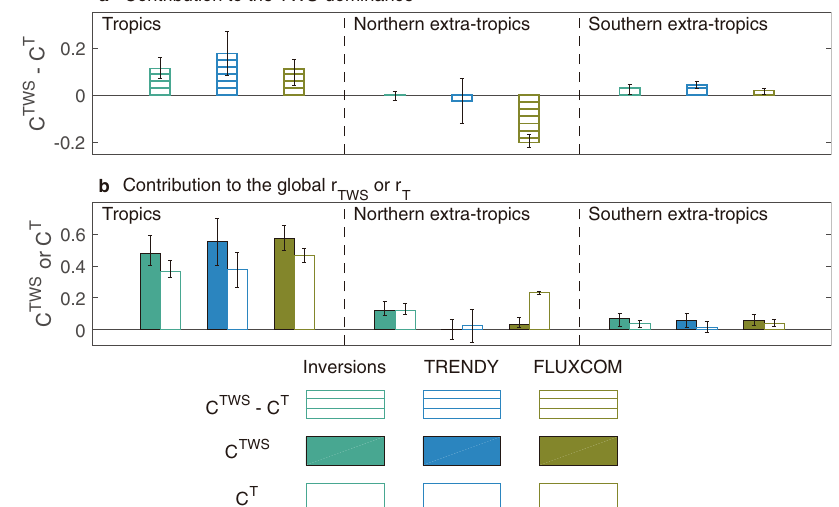
Fig. 2 Contribution of three latitudinal bands to the relationships between global interannual variability of net ecosystem exchange (NEE IAV ) and terrestrial water storage (r TWS ) or temperature (r T ). In panel a , positive values mean that the NEE IAV in the latitudinal band supports the dominance of terrestrial water storage in the global NEE IAV while the negative values mean that the NEE IAV in the latitudinal band supports the dominance of temperature. In panel b , the solid bars are the contributions to the global r TWS (C TWS ) while open bars are the contributions to the global r T (C T ). Positive values of C TWS or C T mean that removing the regional NEE IAV would reduce the absolute value of the global r TWS or r T . In panels a and b , green bars indicate NEE IAV is estimated by atmospheric inversions, while blue bars and brown bars indicate that NEE IAV is estimated by DGVMs from the TRENDY project in simulation S2 (NEE output) and by FLUXCOM models, respectively. For atmospheric inversions and FLUXCOM models, the error bars indicate the range of models while for DGVMs from the TRENDY project, the error bars indicate the 1- σ inter-model